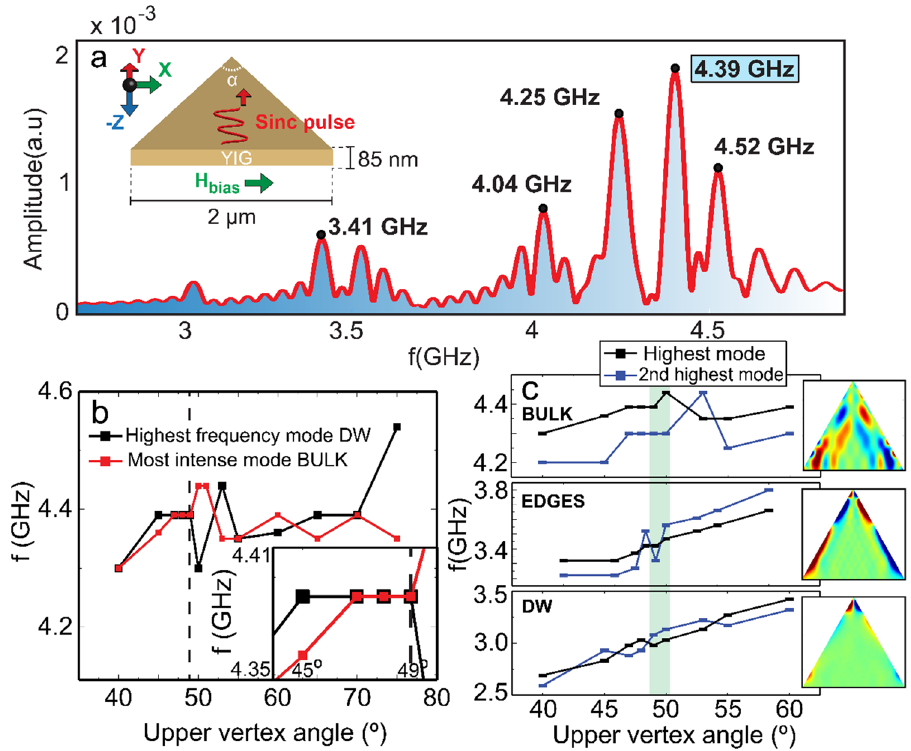
close to it, some DW modes frequencies agree with bulk modes, i.e, when exciting with this frequency they couple and result on a resonant system, which amplifies the transmission through the DW. Inset of b is an enhancement in the high transmission regime, showing the overlapping of modes. c Two most promi- nent modes in the bulk, edges and DW against the corner aper- ture from 40° to 60°. In light green is highlighted the high trans- mission regime. Inset for each graph in c corresponds to a